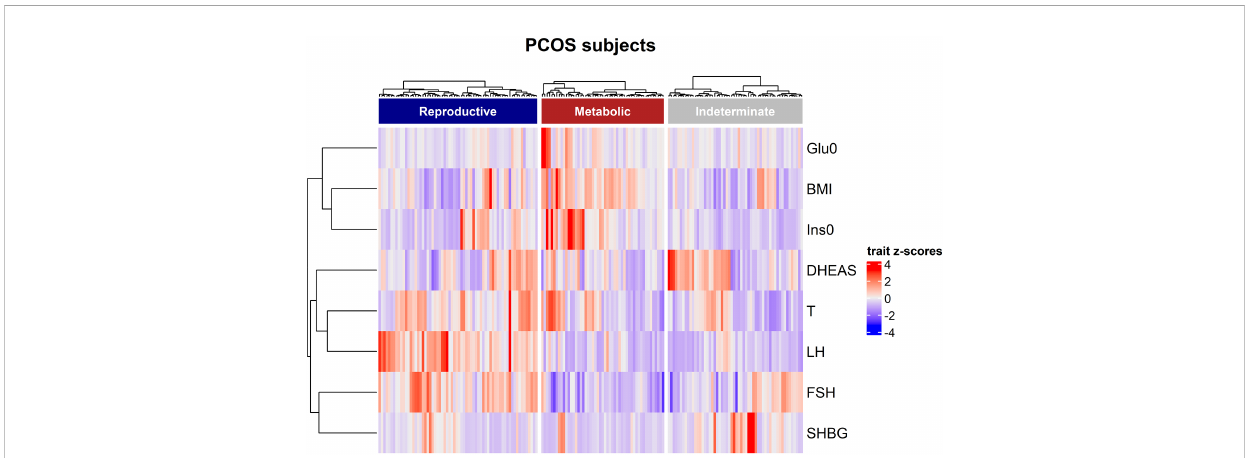
FIGURE 1 Hierarchical clustering of genotyped PCOS clustering cohort. The three clusters are shown as dark blue, dark red, and grey color bars. Heatmap colors correspond with the trait Z-scores, as shown to the right side, in which red implies high values and blue indicates low values for each trait. The trait-based dendrogram represents relative distances between the trait distributions and was calculated using the same approach as that for the subject-based